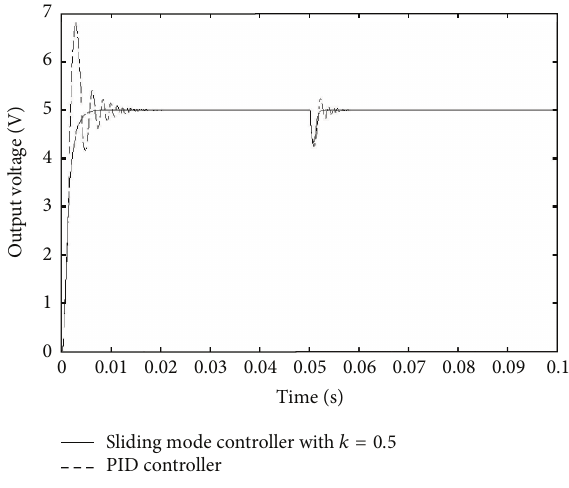
Figure 15: The DC/DC output voltage variation about line variation time.